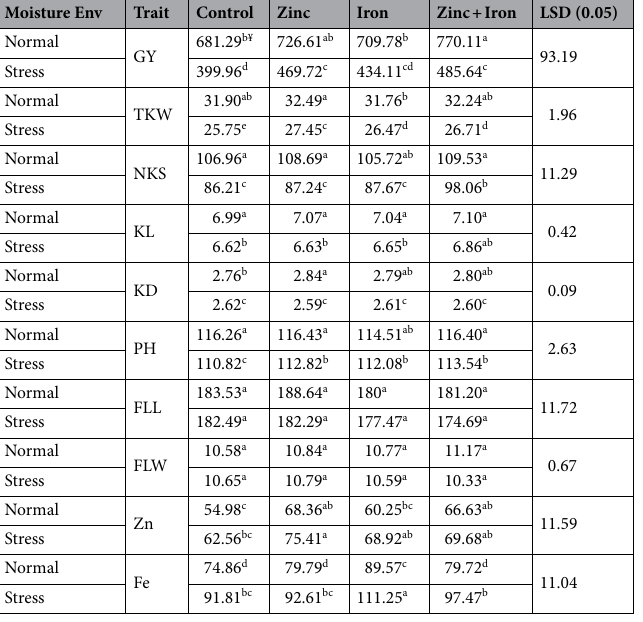
Table 2. Mean comparison of traits in response to foliar application of Zn and Fe under two moisture environments. GY, Grain yield (g/m 2 ); NKS, Number of kernel per spike; TKW, Thousand kernel weight (g); KL, Kernel length (mm); KD, Kernel diameter (mm); PH, Plant height (cm); FLL, Flag leaf length (mm); FLW, Flag leaf width (mm); Zn, Grain zinc content (µg/g); Fe, Grain iron content (µg/g). ¥ For each trait, means followed by the same letter are not significantly different, using LSD test at 5% level of